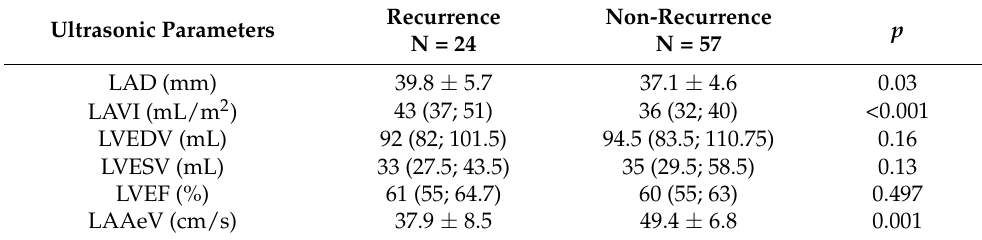
Table 2. Ultrasound